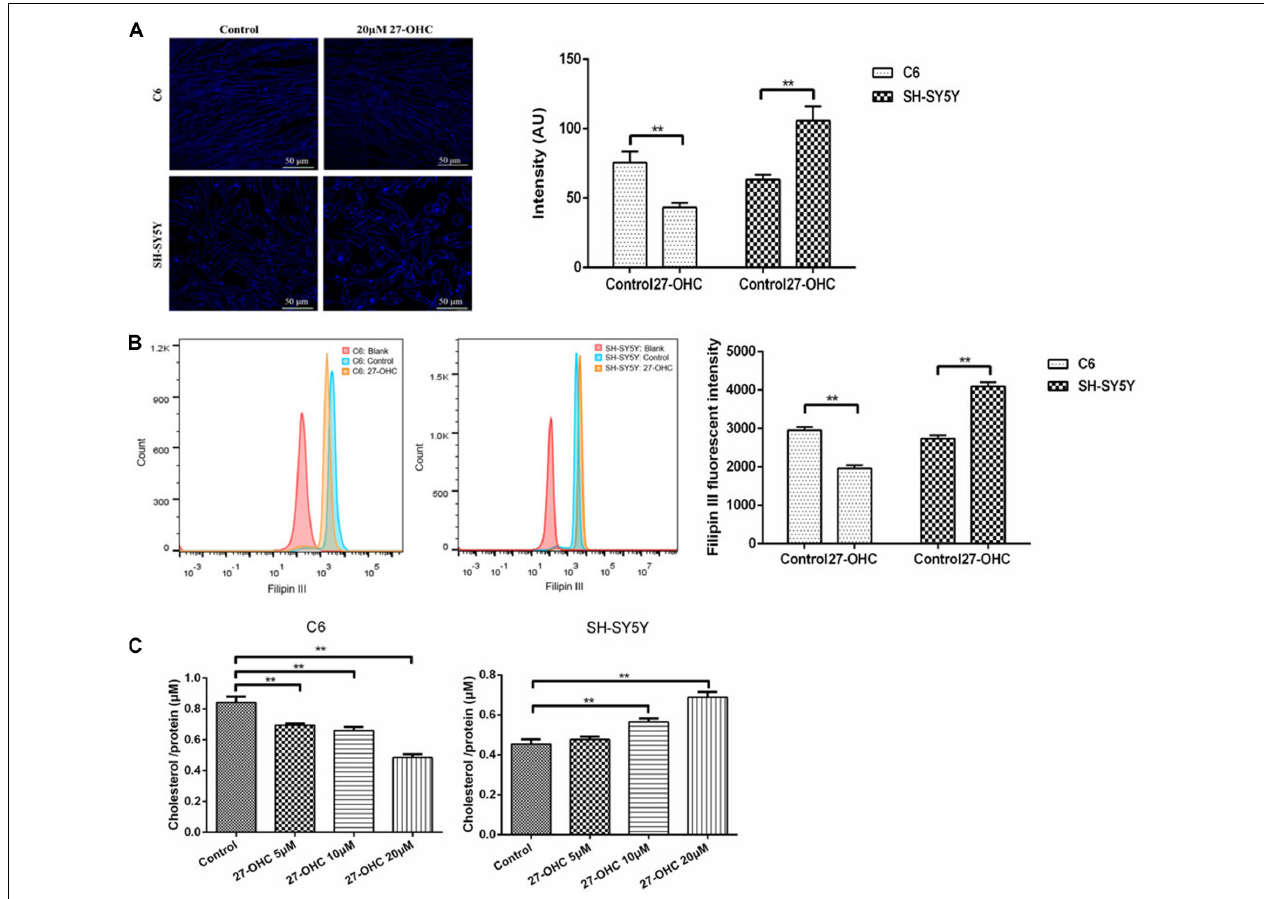
FIGURE 2 | Cholesterol levels in co-cultured SH-SY5Y cells and C6 cells of the control group and 20 µ M 27-OHC treatment for 24 h. (A) Filipin III staining under confocal microscope (scale bar: 50 µ m). (B) Flow cytometry. (C) Amplex Red cholesterol assay. ** P < 0.01 compared with the control